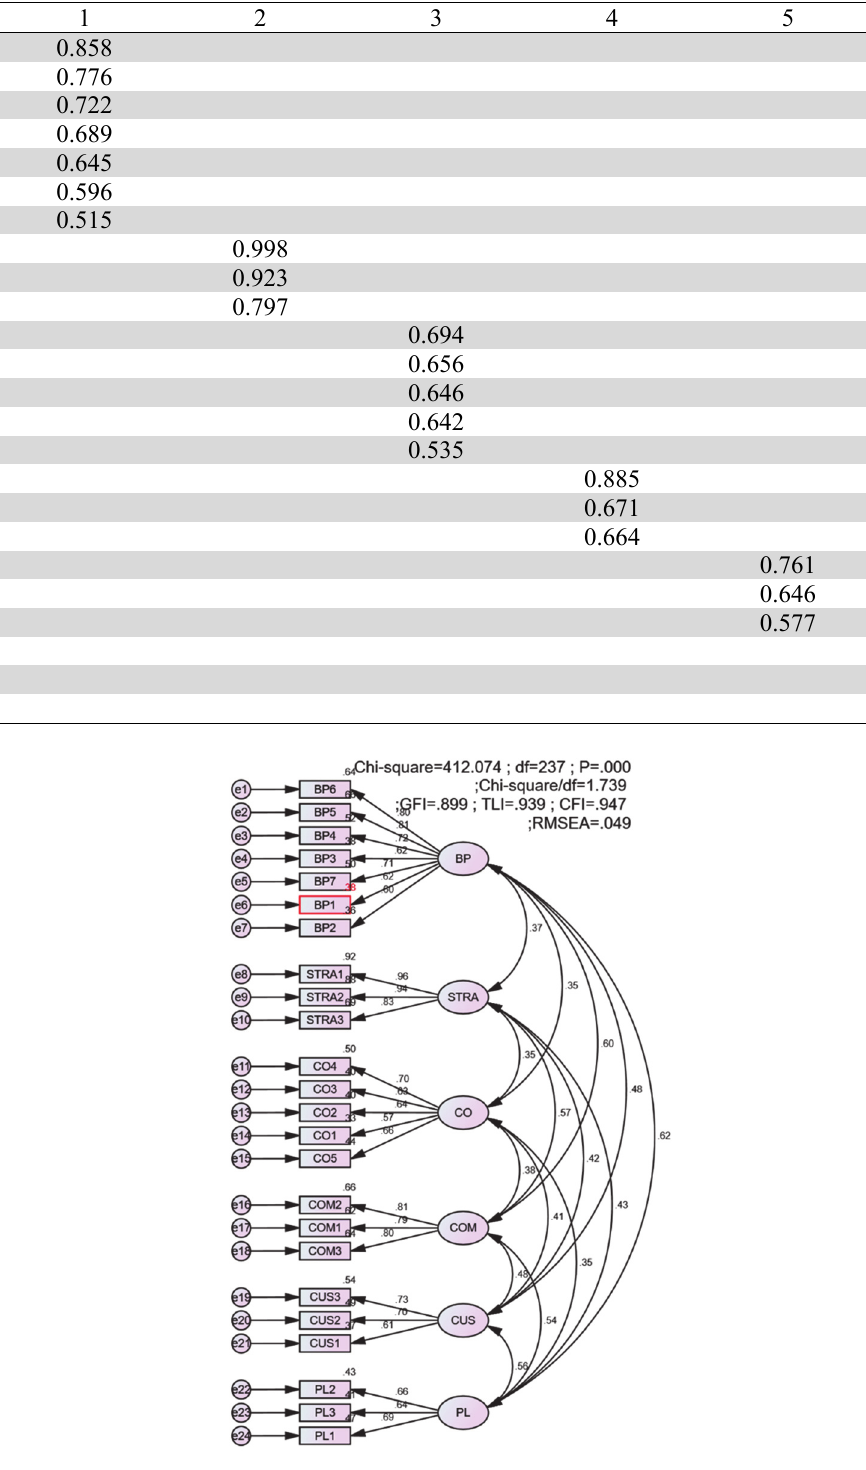
Fig. 3. CFA analysis results for the critical